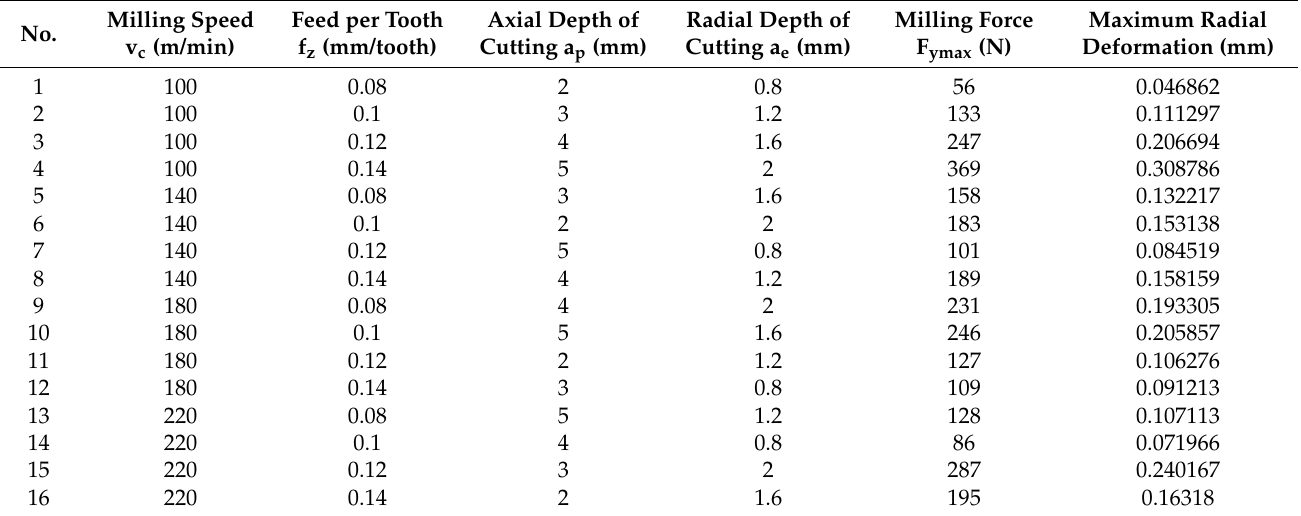
Table 2. Orthogonal experiments’ design table and